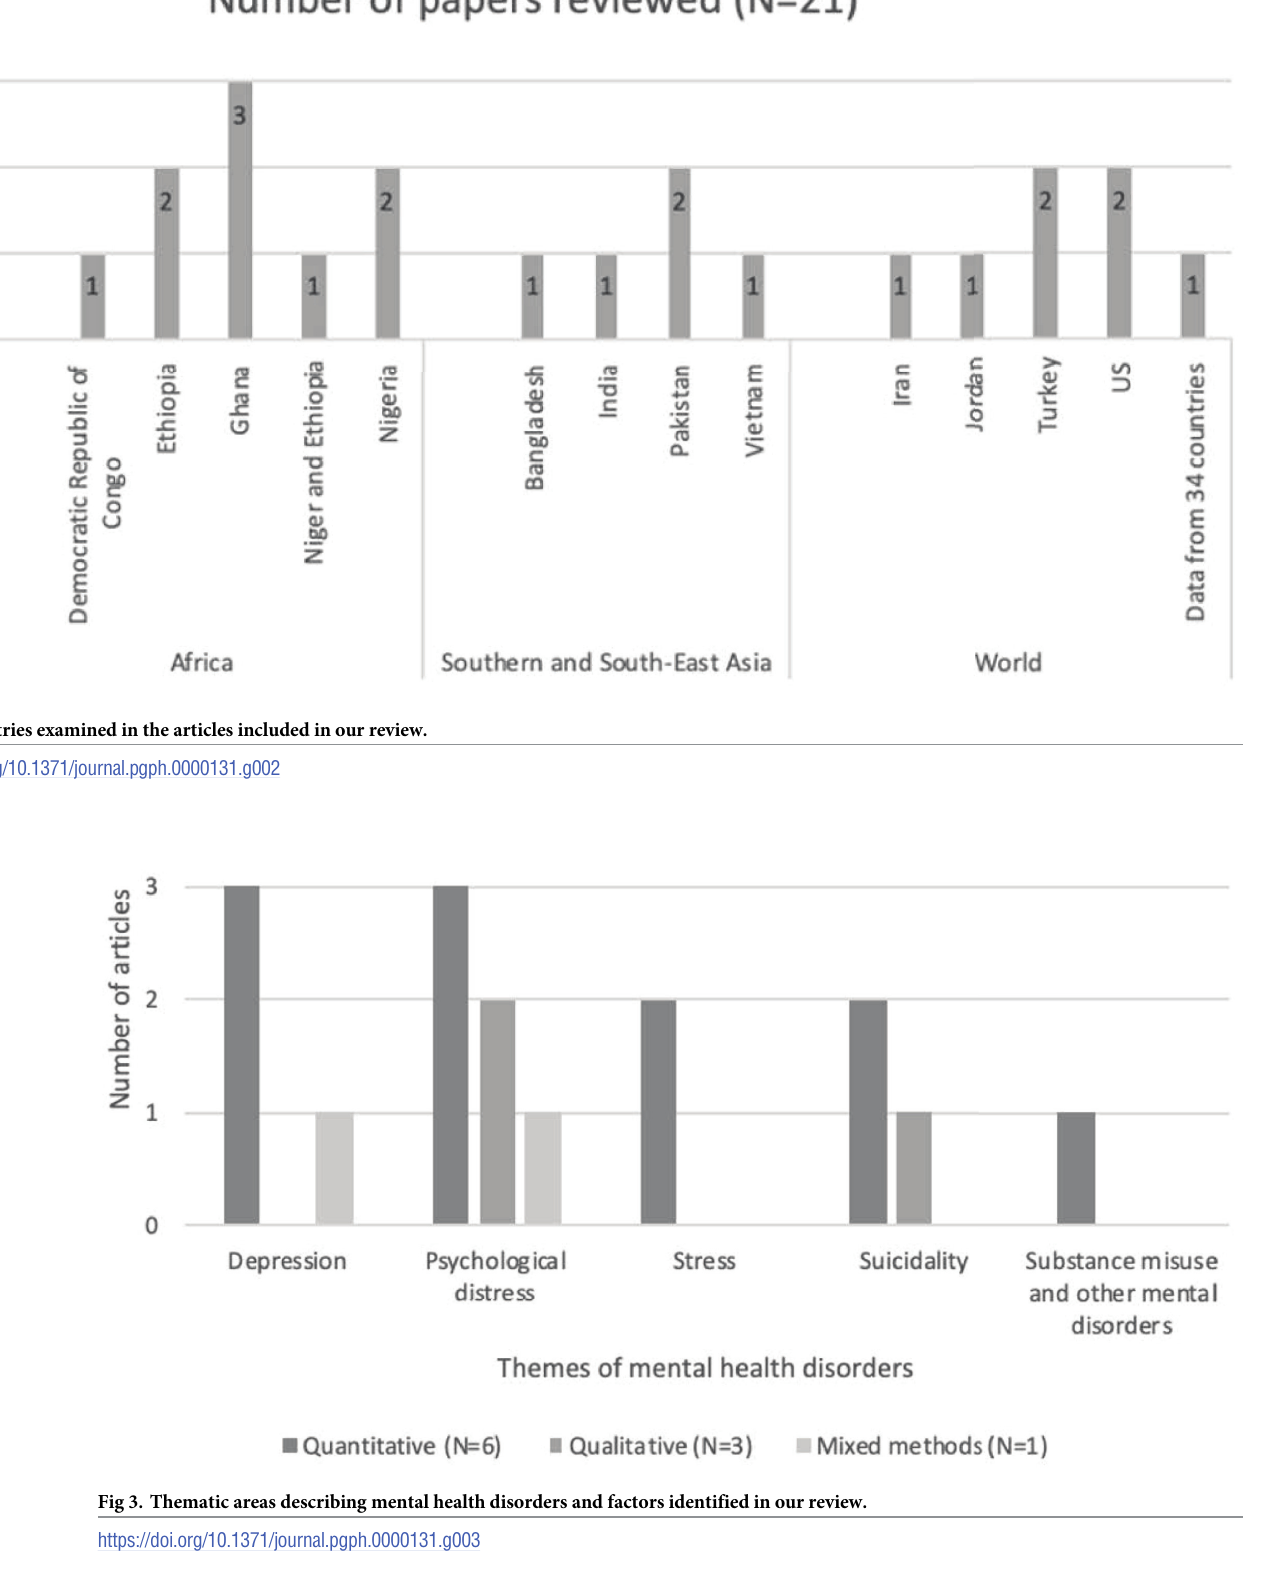
PLOS Global PublicHealth | https://doi.org/10.1371/journal.pgph.0000131 January12,